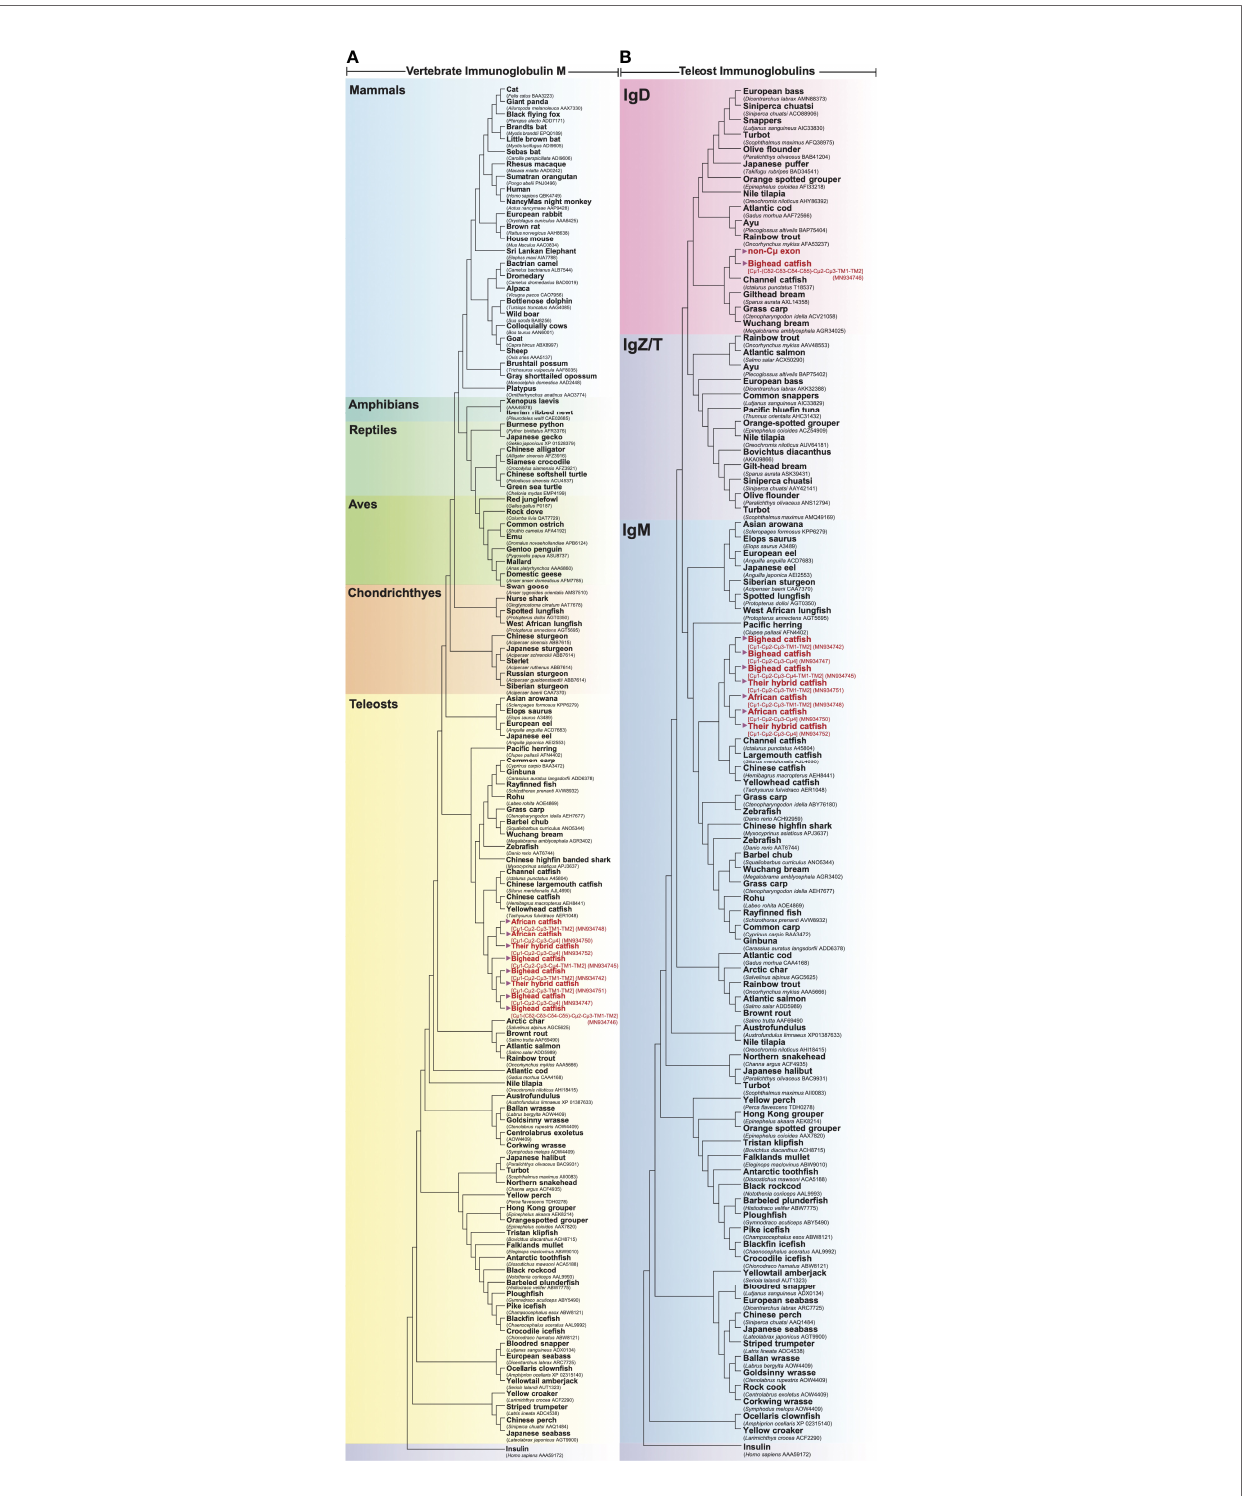
FIGURE 4 | Evolutionary phylogenetic relationship of Igh m between bighead cat fi sh (NCBI accession nos. MN934742, MN934743, MN934744, MN934745, MN934746 and MN934747), North African cat fi sh (NCBI accession nos. MN934748, MN934749 and MN934750), their hybrid cat fi sh (NCBI accession nos. MN934751 and MN934752) and vertebrates, including mammals, amphibians, reptiles, aves, chondrichthyes and other teleosts (A) . Phylogenetic relationship between immunoglobulin heavy chain, IgM, IgD and IgZ/T, expressed in reported teleost fi sh and bighead cat fi sh, North African cat fi sh and their hybrid cat fi sh (B) . Phylogenetic trees were constructed using neighbor-joining (NJ) algorithms with a bootstrap of 1000